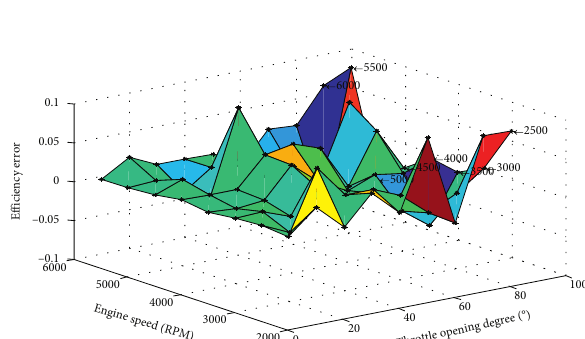
Figure 18: Efficiency error MAP.